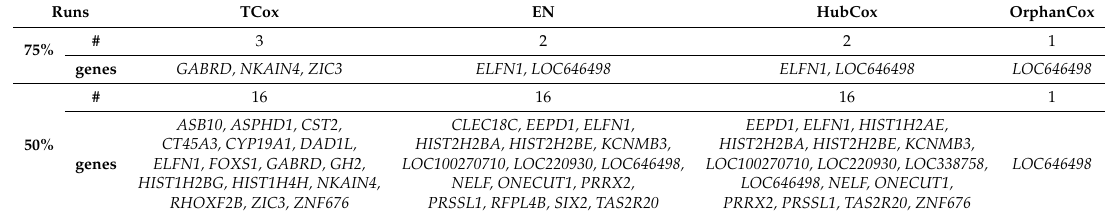
Table 3. List of genes selected for at least 50% or 75% of the runs by all methods tested.